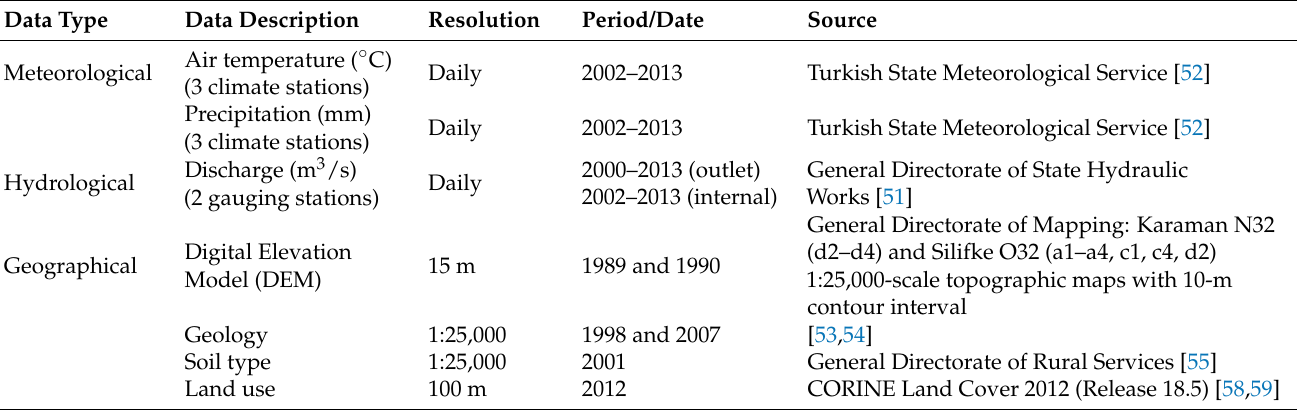
Table 2. Time-series and spatial data used to setup and evaluate the HYPE model in the Alata River Basin (ARB). The periods 2003–2006 and 2009–2013 were used for model calibration and validation, respectively.